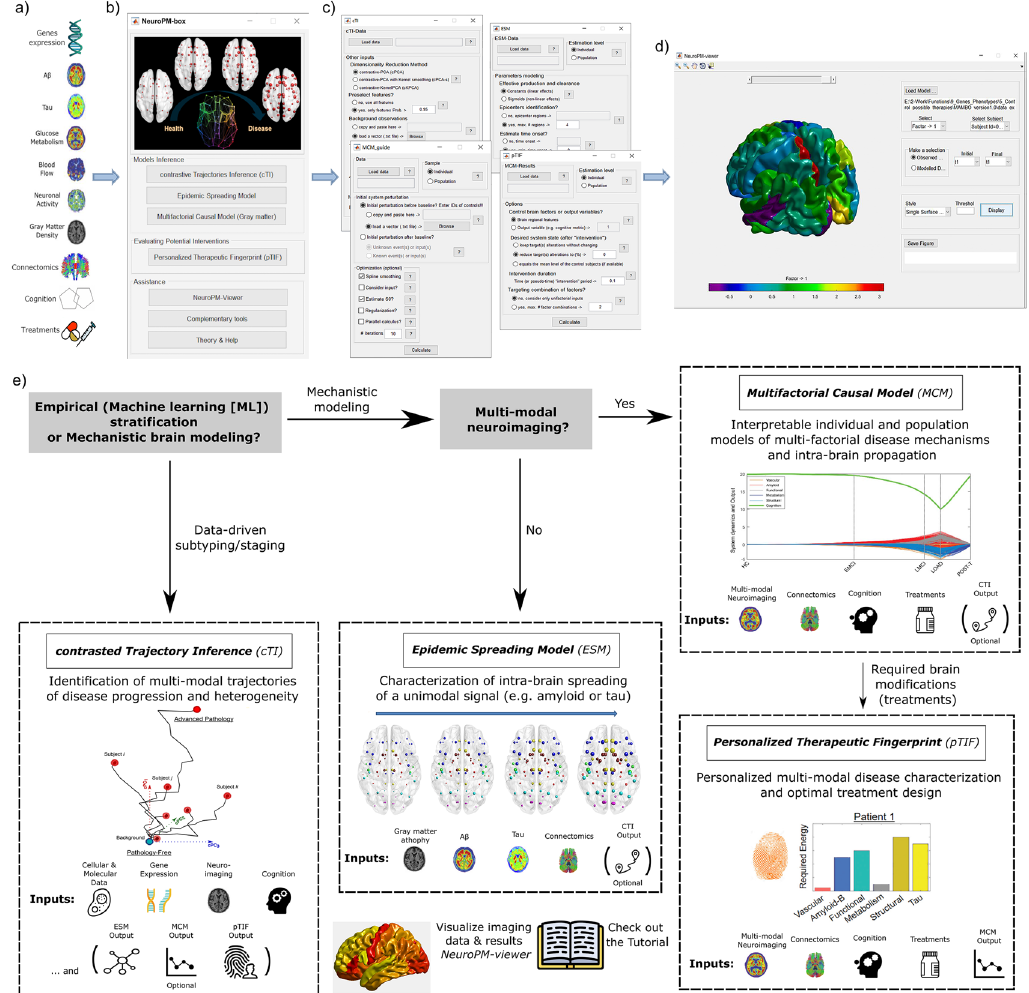
Fig. 1 Schematic for NeuroPM- box software work fl ow and practical guidelines. a The primary software data inputs include molecular (e.g., RNA and proteins concentration arrays), multimodal imaging (e.g., tau, amyloid- β and glucose metabolism PET, vascular, functional, and structural MRI), whole- brain connectomics (e.g., structural and vascular networks), cognitive/clinical evaluations, and therapeutic interventions (e.g. medication). There is no restriction on the number of modalities that can be analyzed. b The NeuroPM- box interface allows users to select from four analytical methods (tools), apply auxiliary applications, and access the visualization tool ( NeuroPM-viewer ) and software tutorial. c Main software modules supporting the data-driven